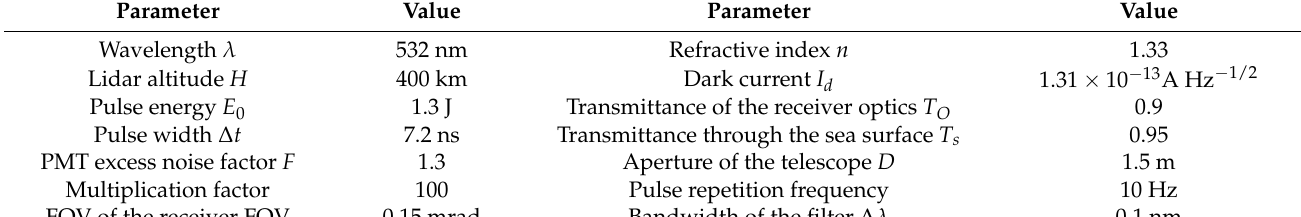
Table 1. Parameters of spaceborne oceanic lidar system.